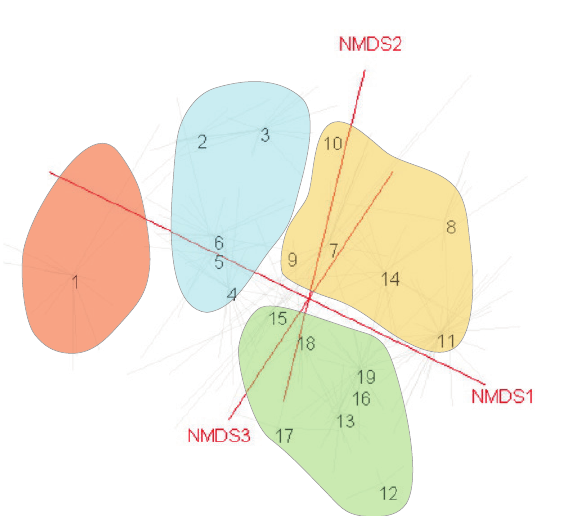
Figure 3. NMDS ordination of tall-forb communities in the Pamir-Alai and western Tian-Shan Mountains. The differ- ent envelopes colors refer to alliances: red – Poion alpinae , blue – Ligulario thomsonii-Geranion regelii , orange – Rhe- ion maximowiczii and green – Scabioso songaricae-Phlo- moidion lehmannianae . Numbers on ordination refer to centroids of clusters (see Syntaxonomic